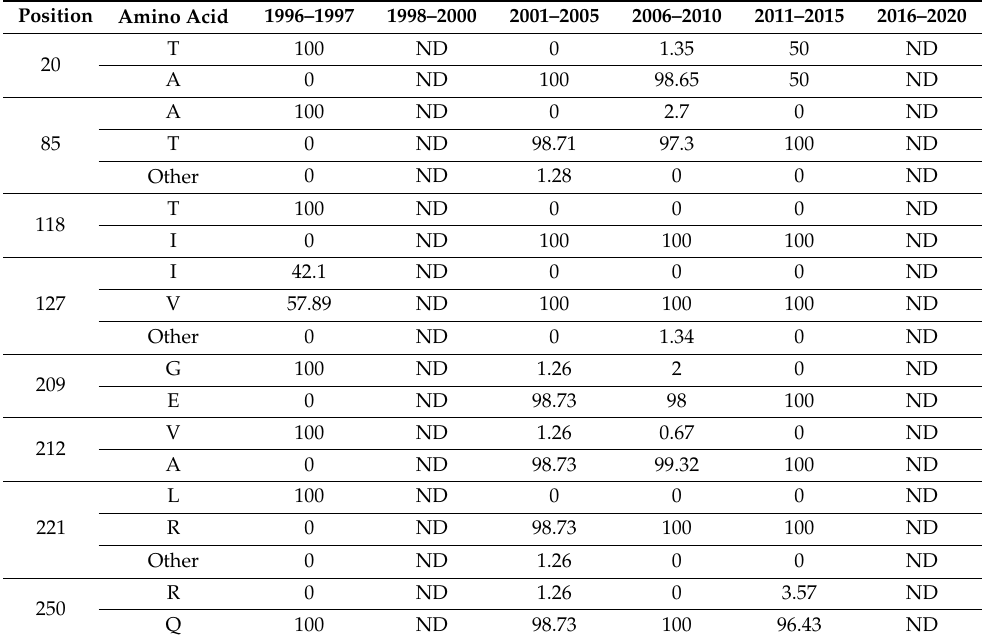
Table 2. Amino acid changes in PA-X proteins from H5N1 IAV isolated in humans.